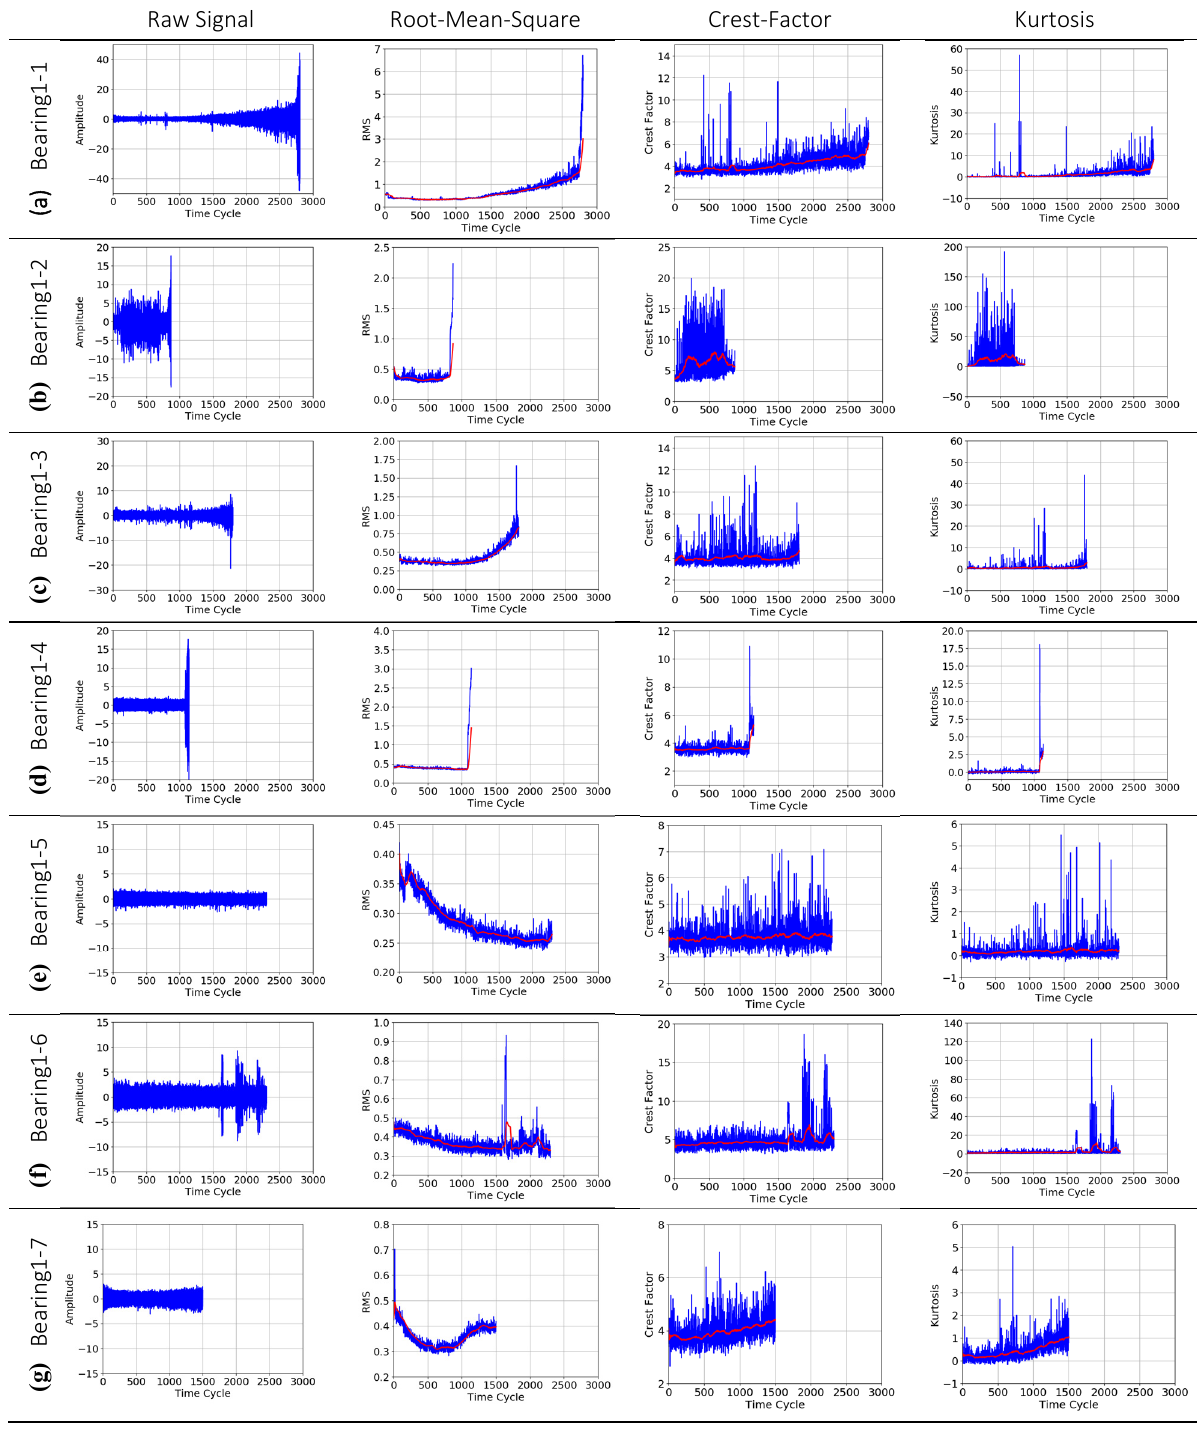
Figure 1. Raw signal, Root-Mean-Square, Crest-Factor, and Kurtosis of bearing instances under the operating condition of 1800 rpm and 4000 N (Note: red lines depict a moving average trend in each chart): ( a ) Bearing1-1; ( b ) Bearing1-2; ( c ) Bearing1-3; ( d ) Bearing1-4; ( e ) Bearing1-5; ( f ) Bearing1-6; ( g ) Bearing1-7. (Note: the all subfigures have the same range of time cycle in x-axis [0–3000] to illustrate very different lifespans of bearings in the PRONOSTIA